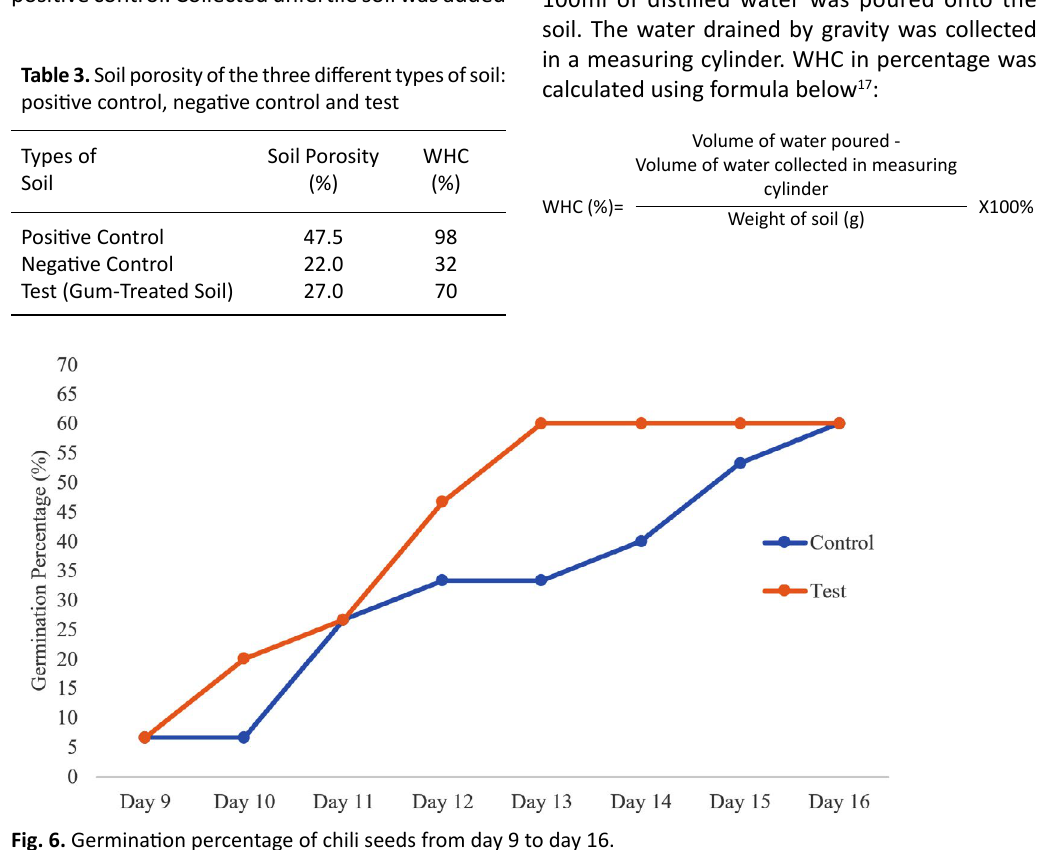
Fig. 6. Germination percentage of chili seeds from day 9 to day